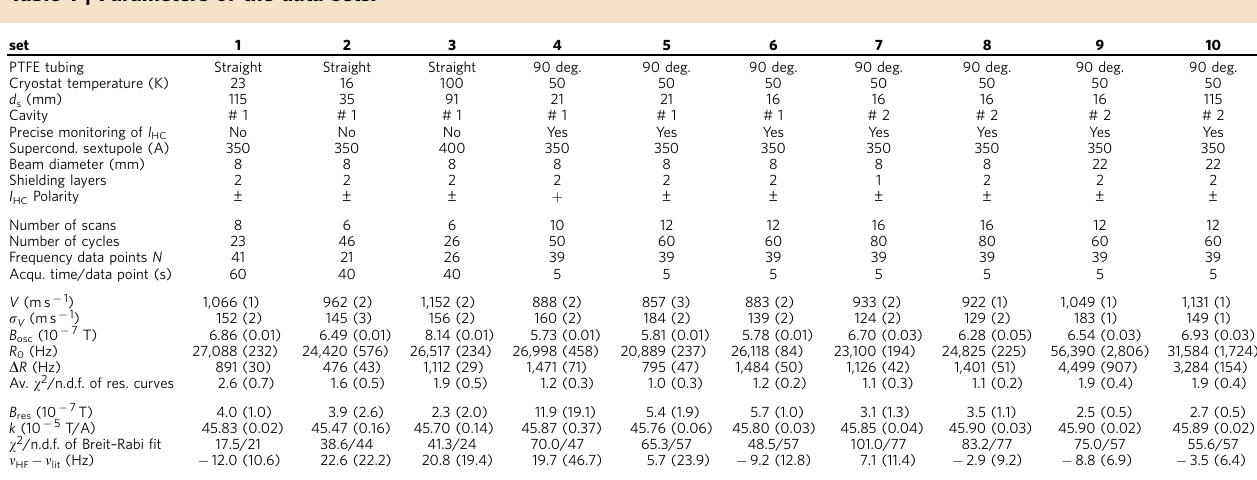
Comparison of the ten sets. The four blocks of rows summarize experimental conditions, statistics of the data acquisition, average fit parameter of cycles together with the average reduced w 2 from applying fit-formula (13), and finally the fit parameters and the corresponding reduced w 2 from applying the Breit–Rabi fit